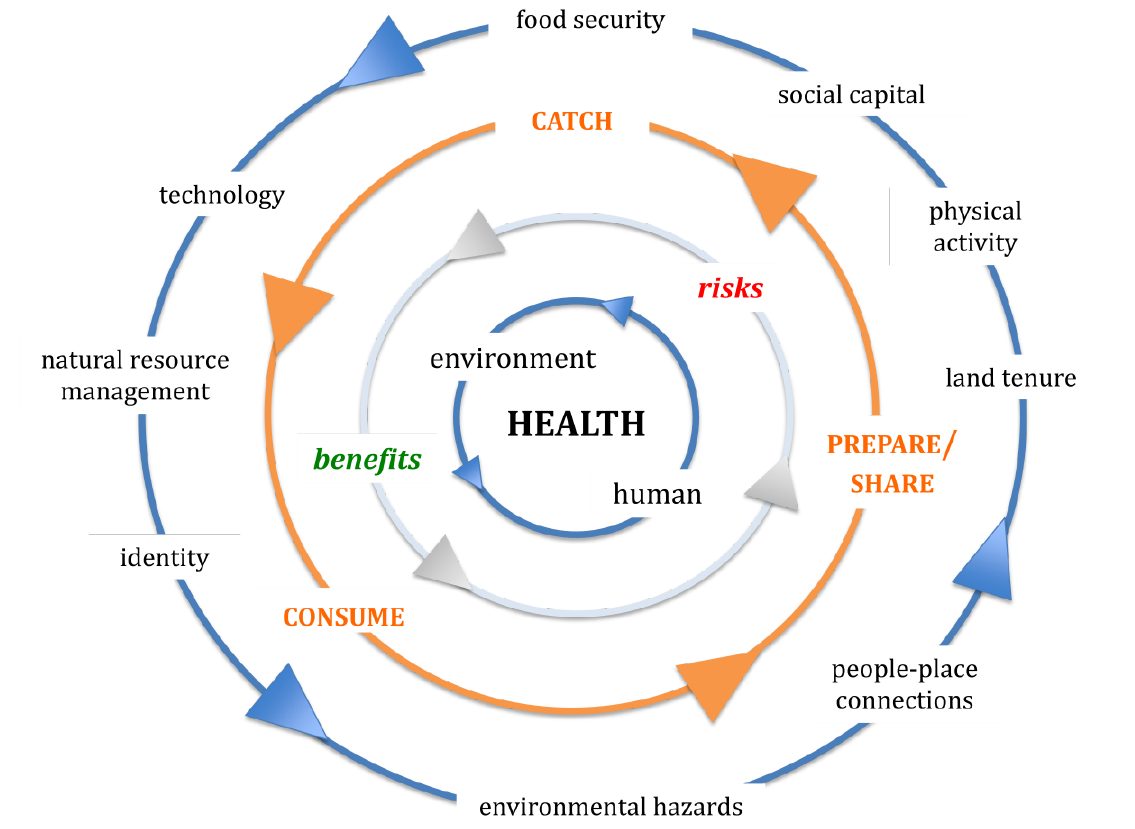
Figure 2. Conceptual model of the interrelationships and key drivers associated with catch, prepare/share and consume aspects of Indigenous land-based